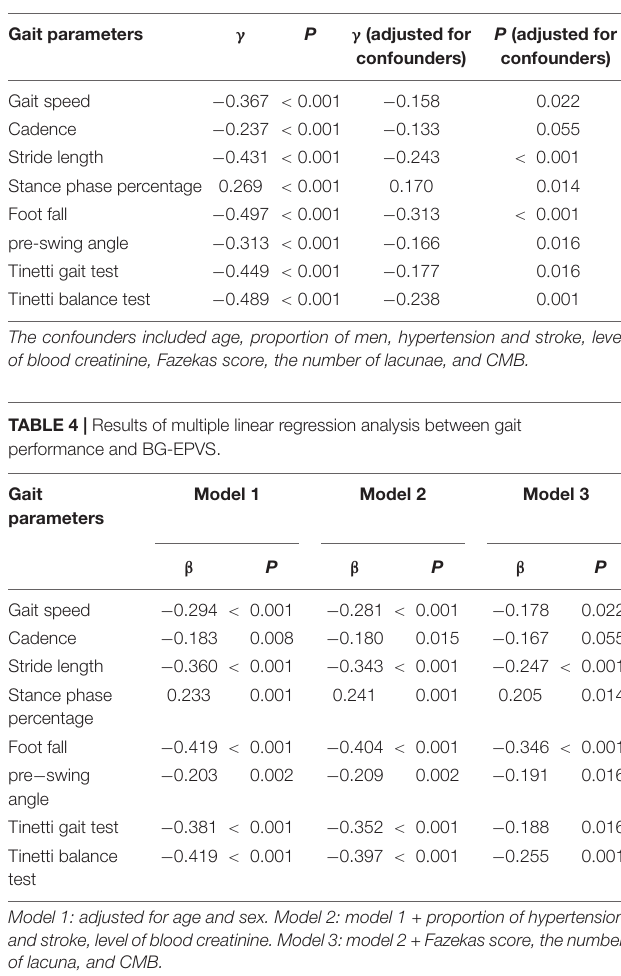
TABLE 3 | Results of correlation analysis between gait performance and BG-EPVS.